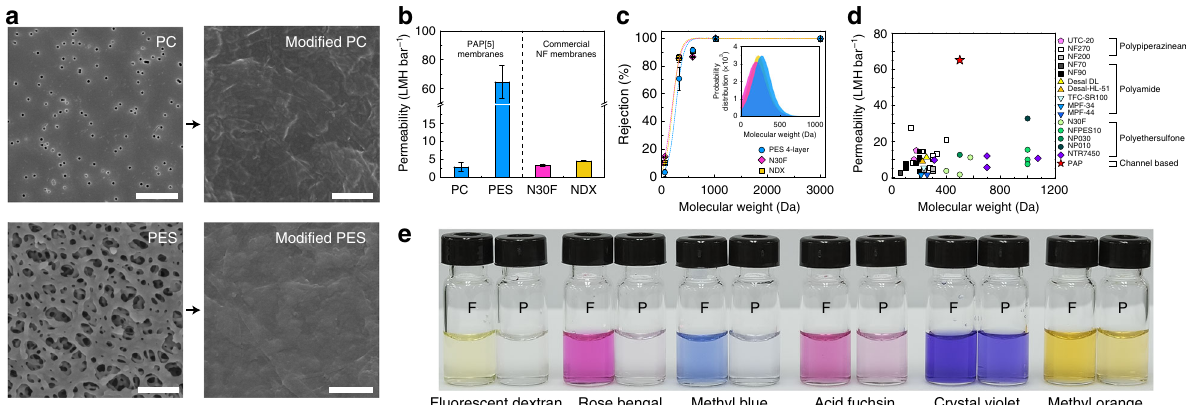
Fig. 5 2D sheets of PAP[5] channels could be assembled into composite membranes and demonstrated enhanced performance compared with current commercial membranes. a SEM images showed ~ 100% coverage of PAP[5] 2D sheets on PC and PES membranes after three and four cycles of layer-by- layer deposition, respectively. Scale bar, 1 μ m. b After three and four cycles of deposition on PC and PES membranes, the permeabilities were 3.0 ± 1.2 LMH bar − 1 and 64.8 ± 11.3 LMHbar − 1 , respectively, (mean± s.d., n = 3). The permeability of the modi fi ed PES membranes is approximately one order of magnitude higher that of commercial nano fi ltration membrane N30F (3.4 ± 0.3 LMH bar − 1 ) and NDX (4.6 ± 0.1 LMH bar − 1 ) with a similar molecular weight cutoff (MWCO). c The molecular weight cutoff (MWCO) was ~ 450 Da, 370 Da, and 360 Da for the modi fi ed PES membrane, commercial N30F and NDX membranes, respectively, as determined from fi ltration of dyes of various molecular weights. The molecular weight cutoff probability distributions derived from fi tting to a sigmoidal model showed the standard deviation ( σ ) of modi fi ed PES (132 Da) membranes was similar to that of N30F (146 Da) and NDX (125 Da). The pore size distribution is tighter for the PES membrane with a σ /MWCO ratio of 0.29 compared with 0.35 – 0.39 for the commercial membranes. The measured rejection values were corrected using a concentration polarization model and all the cutoff data were fi t to a sigmoidal function, as described in Supplementary Methods. d A comparison of PAP[5] channel-based membrane to other commercial NF membranes shows that within the cutoff range (400~500 Da), the channel-based membrane has one order of magnitude higher permeability and in general is several times higher that of commercial nano fi ltration membranes across the complete range of available data on such membranes from literature 50 – 64 . e Photographs of feed (F) and permeate (P) containing different dye molecules (decreasing MW from left to right in image) for modi fi ed PC membranes. Both positively and negatively charged dyes had similar rejections as shown in Supplementary Fig. 27. Data shown are the average of triplicate measurements with